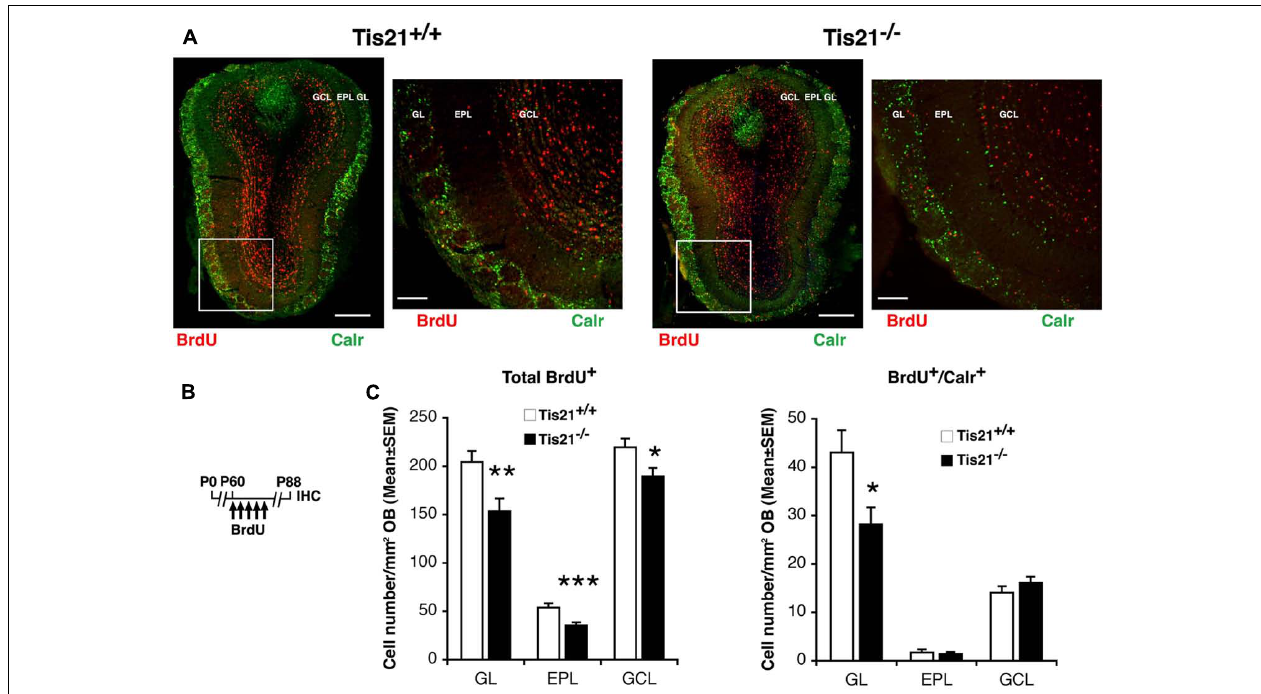
FIGURE 6 | Tis21 deletion results in decreased numbers of SVZ neuroblast-derived granule cells in the olfactory bulb. (A) Representative confocal images (coronal sections) of the olfactory bulb in P88 Tis21 + / + and Tis21 − / − mice, showing terminally differentiated 28-day-old neurons, identified as total BrdU + cells or as Calretinin + neurons (red and green, respectively). On the right are higher magnification images of the regions in white boxes. Scale bars, 300 and 100 μ m (enlargement). In the glomerular layer a decrease is evident of the BrdU + /Calretinin + interneurons, derived from the SVZ neuroblasts that have migrated locally and terminally differentiated. (B) Scheme of BrdU treatment, with five daily BrdU injection